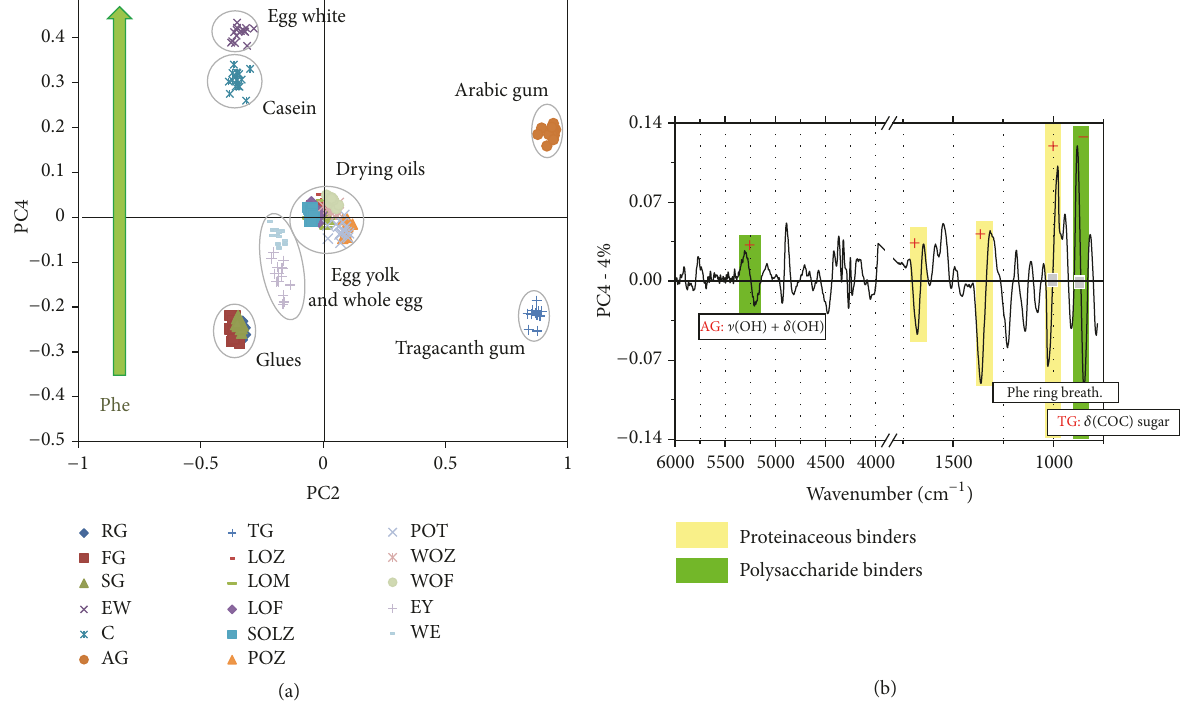
Figure 7: PCA applied to combined FT-NIR and Raman spectra, taking into account all neat binding media: score plot of PC2-PC4 (a) and loading plot of PC4 (b), highlighting proteinaceous and polysaccharide